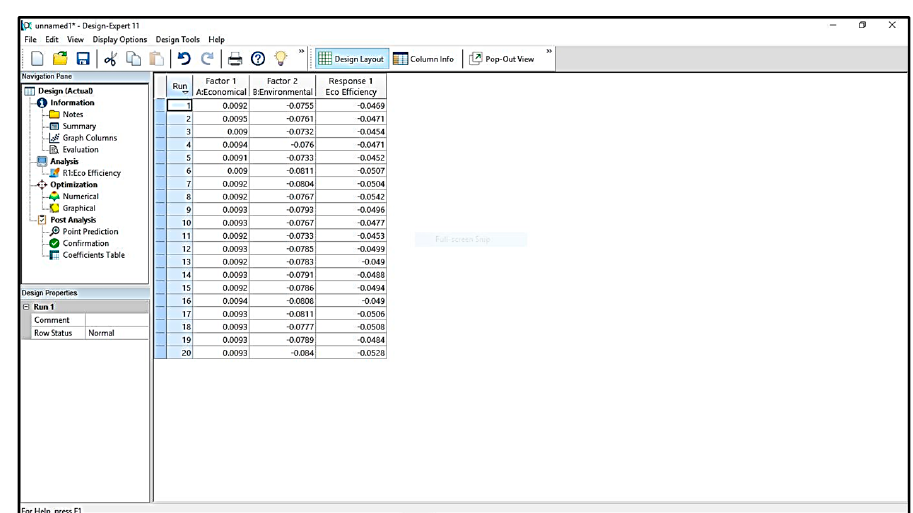
Figure 5. Data Input for Factor and Response.